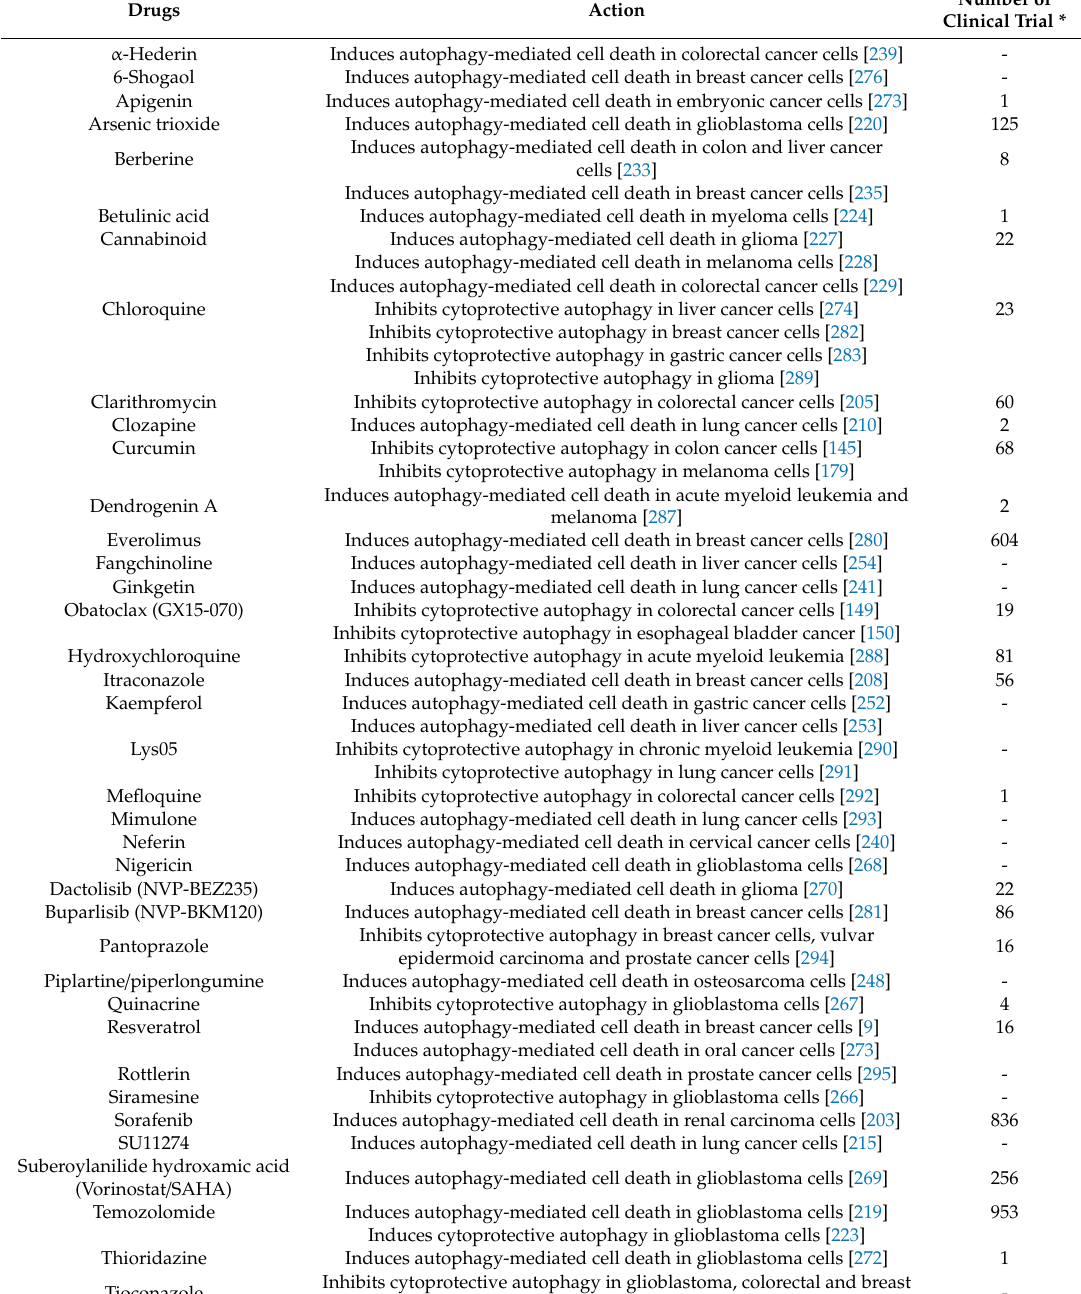
Table 1. Autophagic modulating drugs in